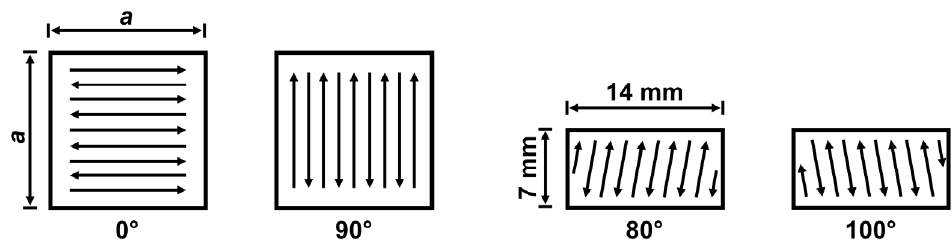
Figure 1. Specimen geometries and scanning vector orientations.